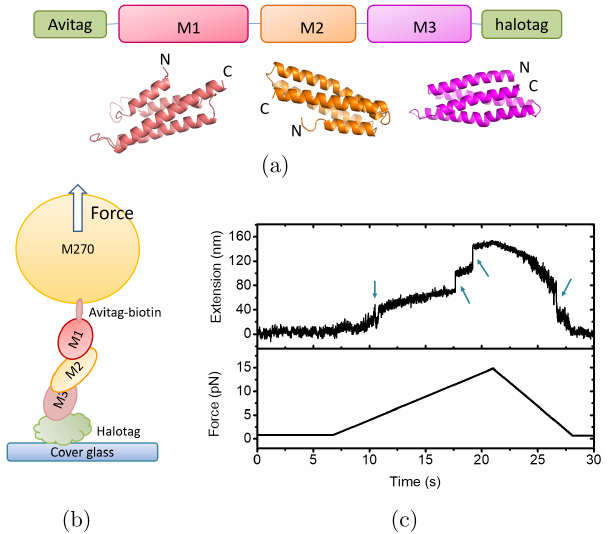
Fig. 1. Domain map of (cid:1) -CM protein construct, schematic experimental setup, and typical experimental data. (a) Protein construct of (cid:1) -CM protein is linked with avitag at N-terminus and halotag at C-terminus. Structures of modulation domains M1 (residues 277 – 393), M2 (residues 394 – 506), and M3 (resi- dues 507 – 631) are adopted from crystal structure (PDB: 4IGG). (b) In magnetic tweezer experiment, (cid:1) -CM protein is linked between cover glass surface and a paramagnetic bead M270 through which pulling force is applied to protein mole- cule. (c) During magnetic tweezer experiment, force is con- trolled by the instrument (bottom panel), and extension of protein is measured in real time by analysis of bead images (top panel). Originally, force is set as 0.78pN and protein is at folded native conformation. Then force increases linearly to 15 pN with loading rate of 1 pN/s. After that, force decreases linearly to 0.78 pN with loading rate of (cid:2) 2pN/s. The measured ex- tension changes smoothly when there is no conformation transition, and jumps up suddenly when unfolding transition happens and jumps down suddenly when folding transition happens (indicated by